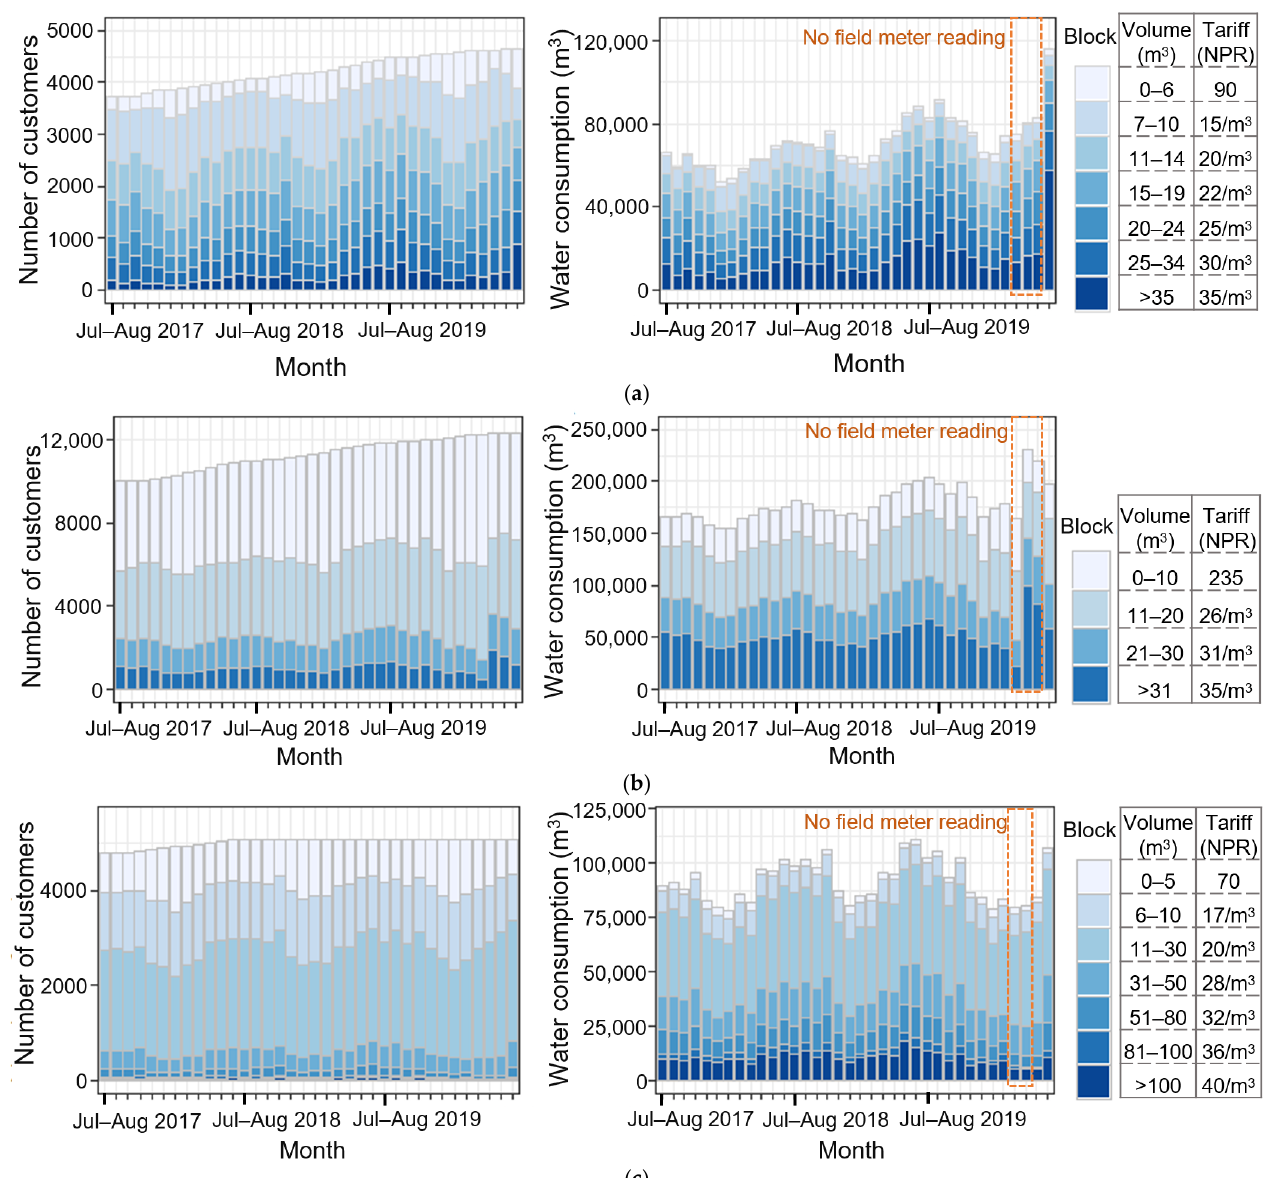
Figure 4. Customer numbers and water consumption distribution based on block tariff 1 : ( a ) Birat 2 , ( b ) Lekhnath 2 , and ( c ) KWUSA 2 . 1 As per FY 2019–2020 tariff structure. 1 USD ≈ 115 NPR. 2 The height of each bar shows the total number of customers ( left ) and total water consumption ( right ) in each month, the color stack bars indicate those of the customers grouped by their monthly water consumption as shown in the legend.